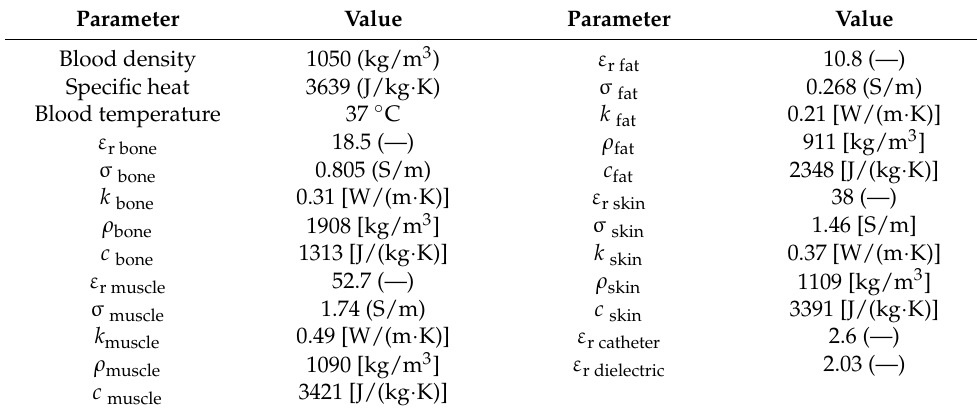
Table 1. Tissues and antenna properties used in the FEM models [26].